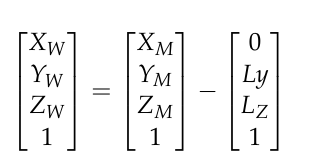
Figure 4. Relationship of the mmWave radar coordinate system, the camera coordinate system and the world coordinate system.